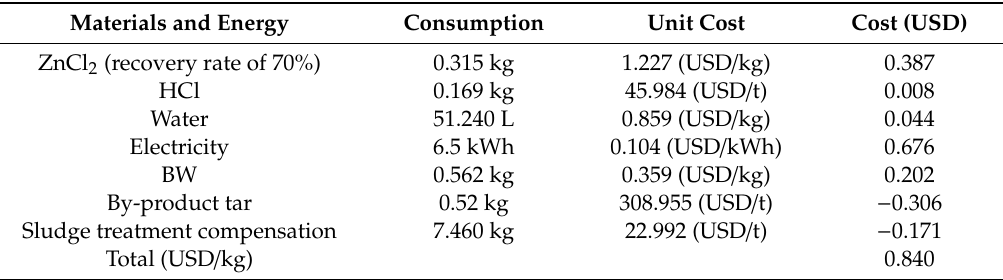
Table 5. Cost analysis of